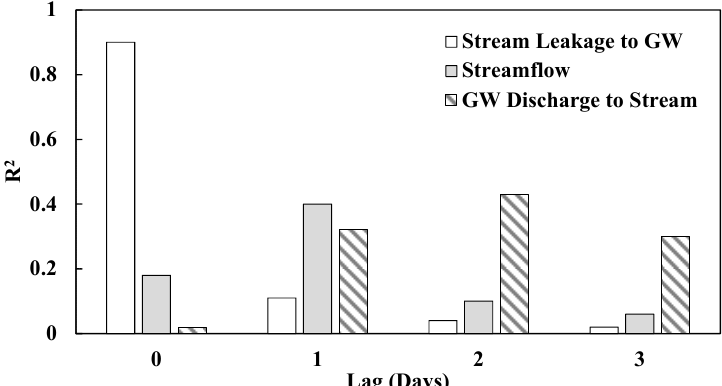
Figure 15. Lag correlations between the precipitation and stream leakage to the groundwater (GW), streamflow and GW discharge to the streams on a daily time scale.